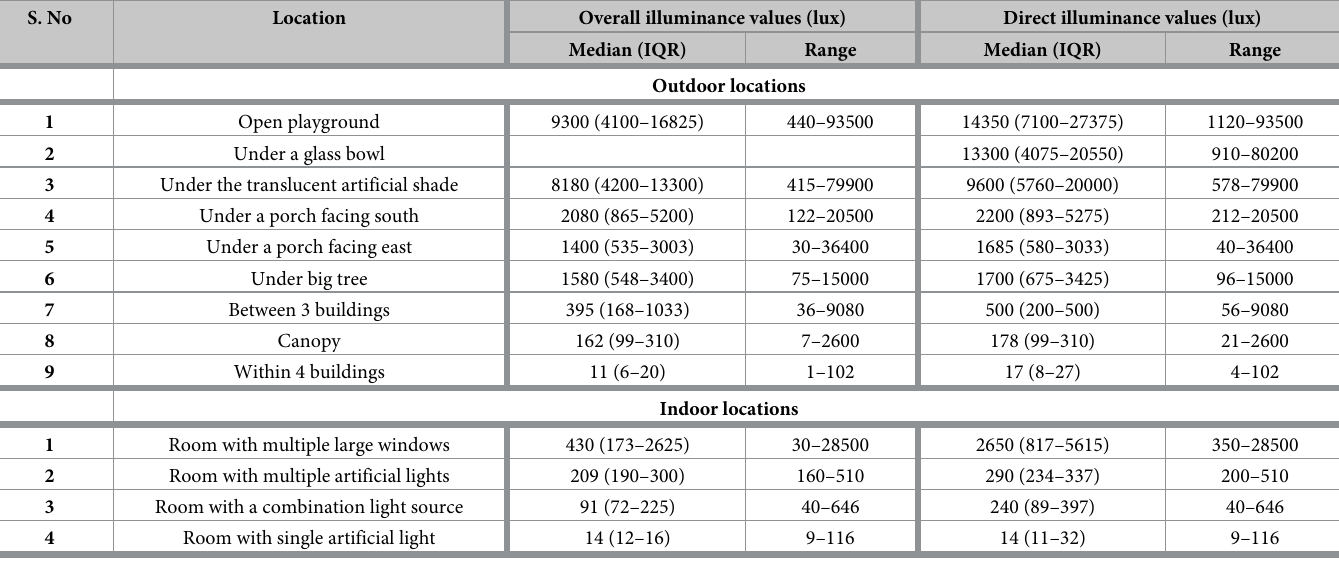
Table 2. Overall and direct median (IQR) illuminance levels with range recorded in different outdoor and indoor locations (irrespective of the time of the day, sunny or cloudy weather, relative sensor source positions, use of sun protection, and summer and winter season).